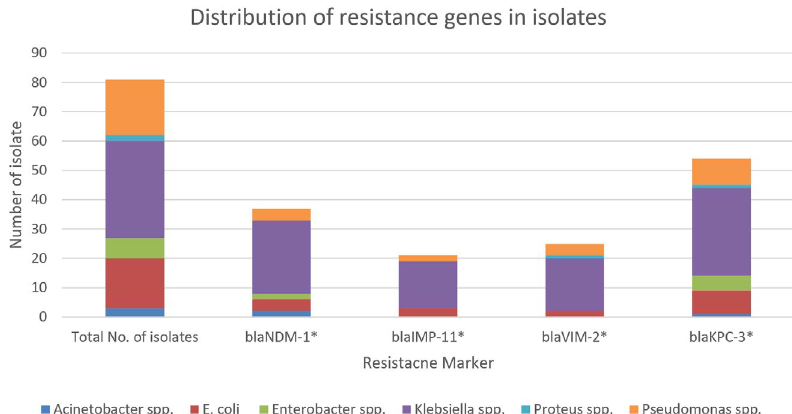
Fig. 5. Molecular characterization and Carbapenem gene distribution in clinical isolates.